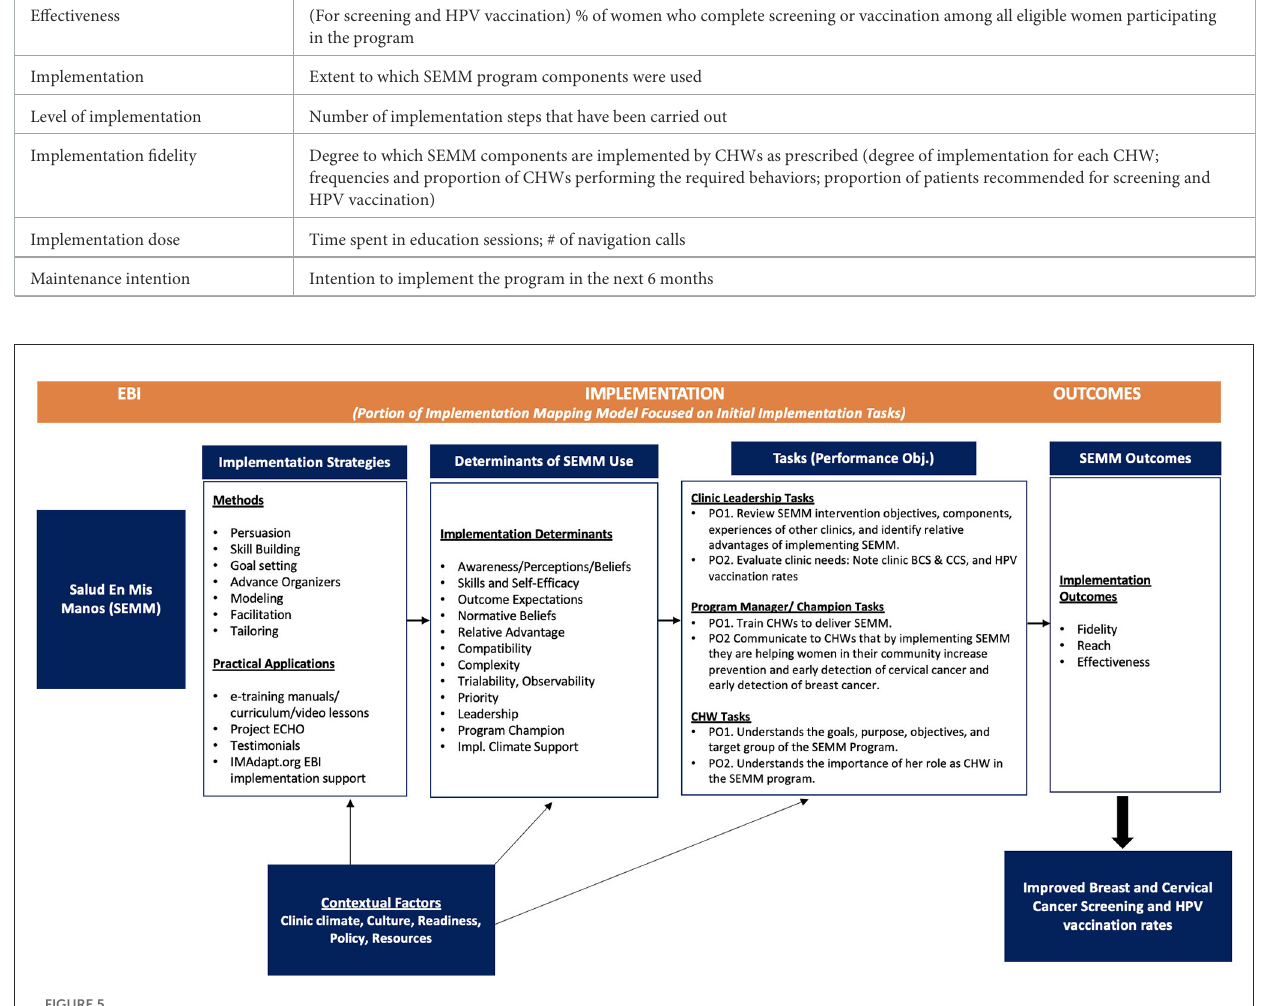
FIGURE5 SEMM-DIA Implementation Mapping logic